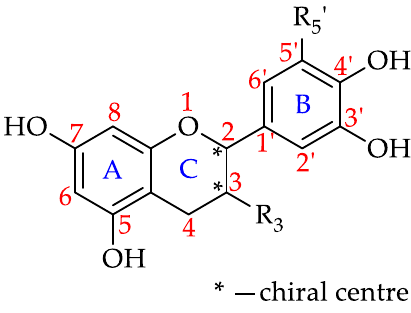
Figure 11. Basic flavan-3-ol structure (see 73 – 80 in Table 6). Table 6. Flavan-3-ols reported in monofloral honeys (see Figure1 for general structure).